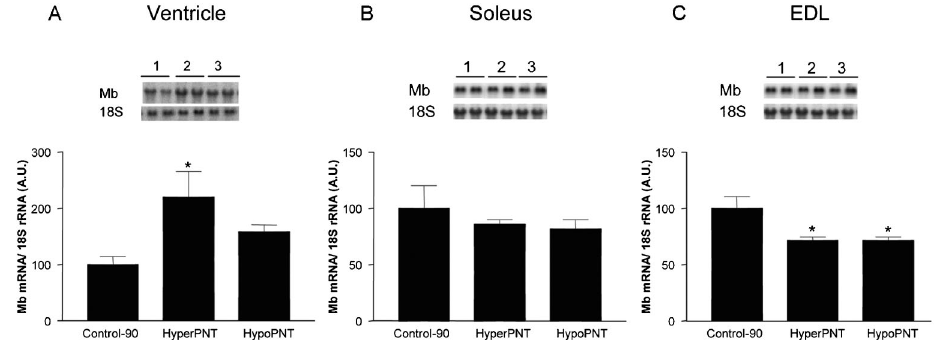
Figure 3. Effect of transient postnatal hyper- and hypothyroidism from postnatal (P) day 0 to P30 on molecular programming of myoglobin gene expression in ventricle ( A ), soleus ( B ) and extensorum digitalis longus (EDL) ( C ) muscles of 90-day-old rats. Northern blot analysis of ventricle, soleus, and EDL Mb mRNA levels of rats subjected to vehicle (control-90), T 3 (4 m g/100 g BW, HyperPNT) and PTU (5 mg/100 g BW, HypoPNT) treatment from P0 through P30, and allowed to grow with no further treatment until 90 days of life, is shown at the top of each panel, and the quantitative results obtained by densitometric analysis of Mb and 18s rRNA transcripts hybridization ratio is shown at the bottom, in arbitrary units (A.U). Data are reported as means±SE of 12 animals/group. *P , 0.05 vs control-90 (ANOVA).